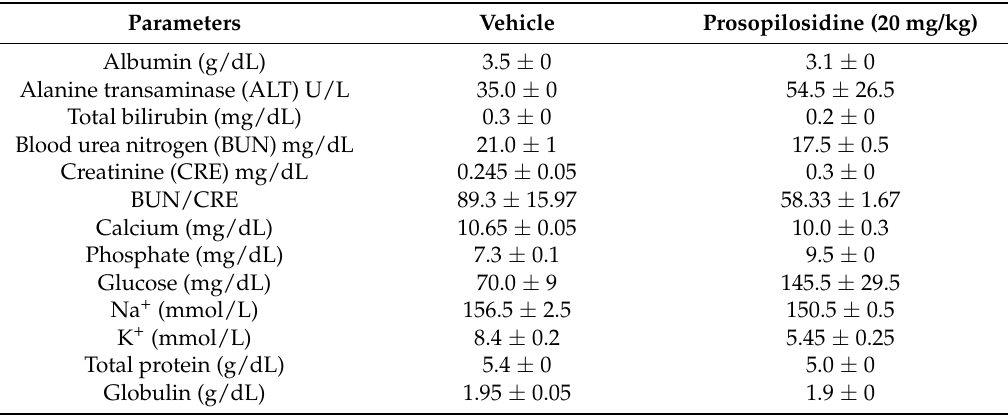
Table 2. Blood chemistry profile of mice administered Prosopilosidine at 20 mg/kg via the oral route. All values are expressed as mean ± SEM ( n = 3).